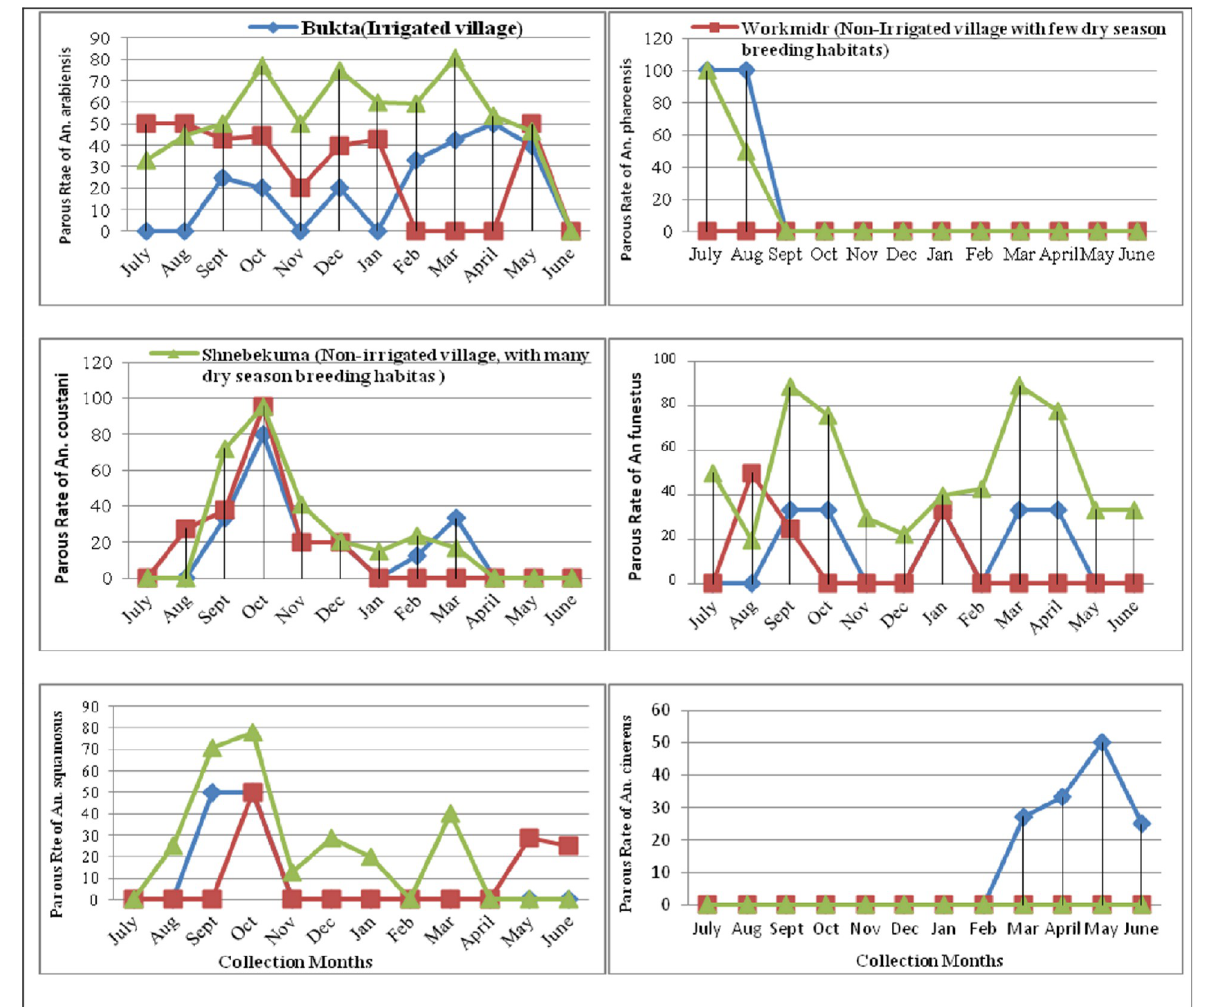
Fig 2. Mean parous rates of Anopheles mosquito in three villages, Bure district, Ethiopia (July 2015—June 2016).